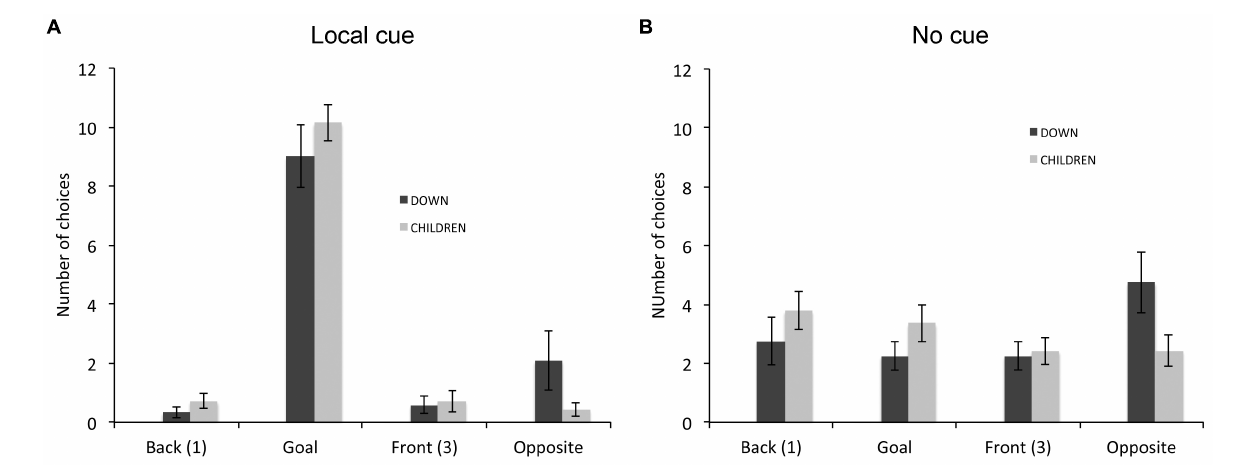
FIGURE 5 | Proportion of choices (goal location (2), opposite location (4), back location (1), or front location (3), as the first choice upon entering the arena; mean ± SEM) made by individuals with DS and TD children, who did not perform above chance level the response learning task, in presence (A) or absence (B) of a local cue marking the reward